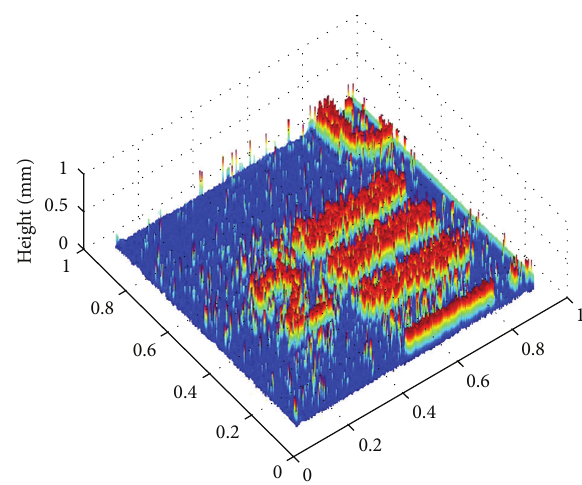
Figure 7: The reconstructed height distribution.